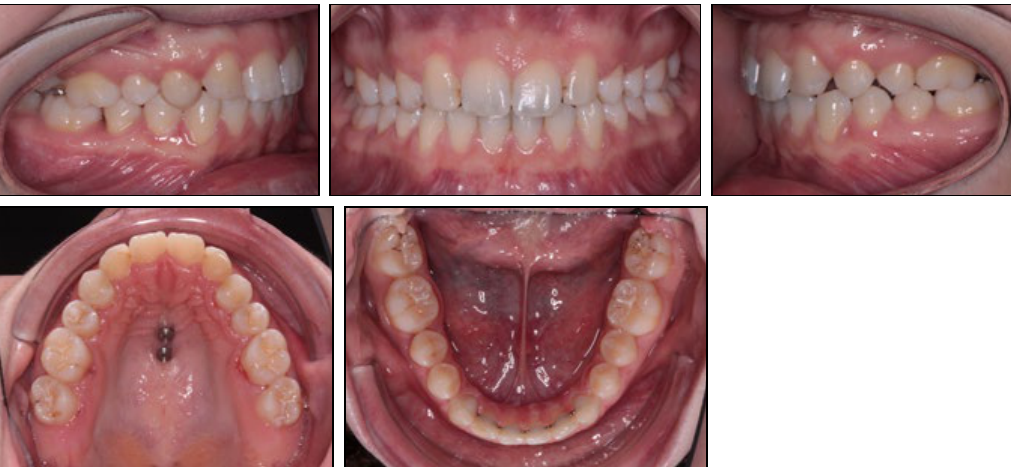
Figure 13. Intraoral photographs after debonding of the fully indvidualised lingual appliance (WIN®).